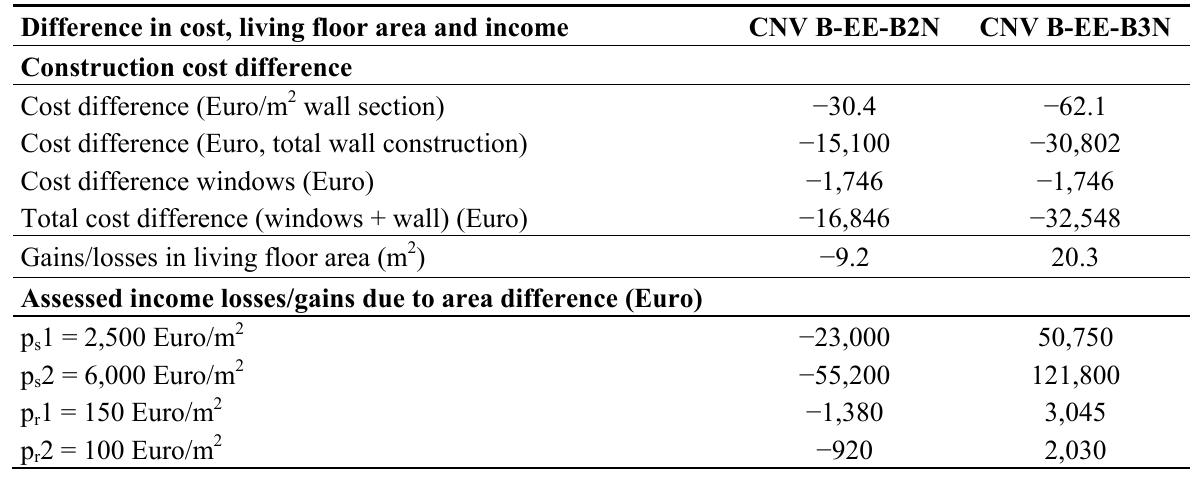
Table 12. Cost difference and assessed living area lost between conventional and energy-efficient building constructed with new product, brick house.